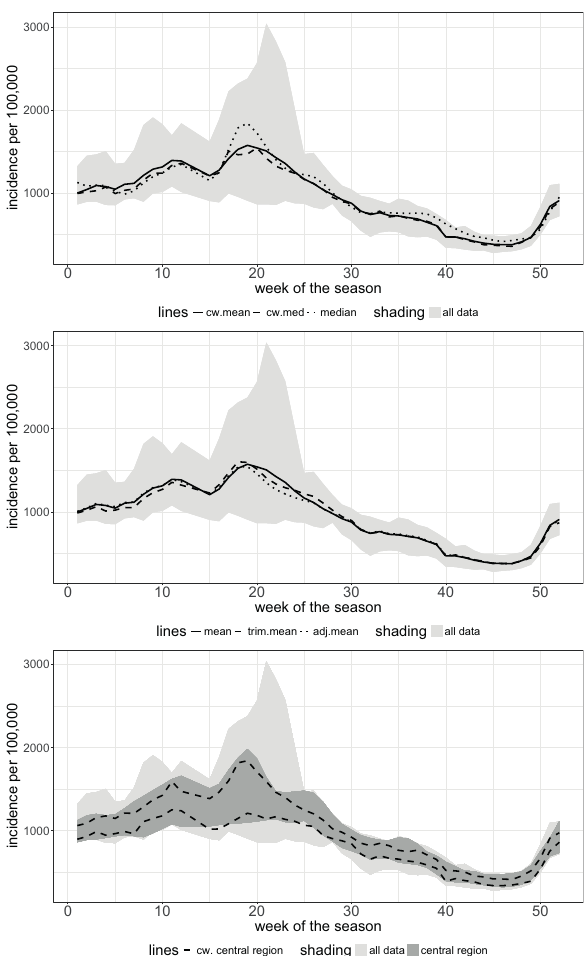
Fig. 4. Comparison of the methods for the detection of the base- line incidence: componentwise mean, componentwise median, and median (left), componentwise mean, trimmed mean, and adjusted mean (middle); comparison of the 50% central regions gained by the componentwise and functional methods